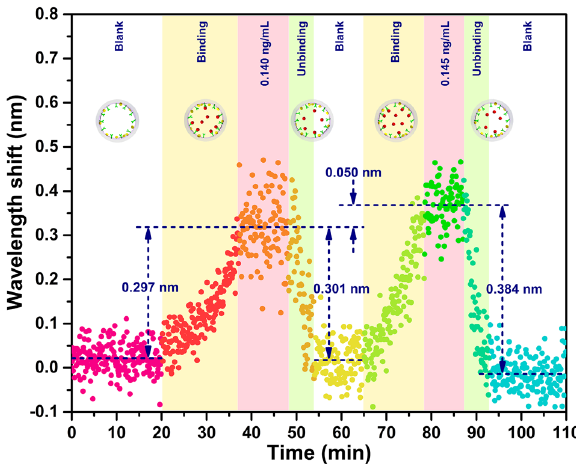
Figure 10: Dynamic response of the peak wavelength shift of the sensing laser to the binding and unbinding process of cTnI-C